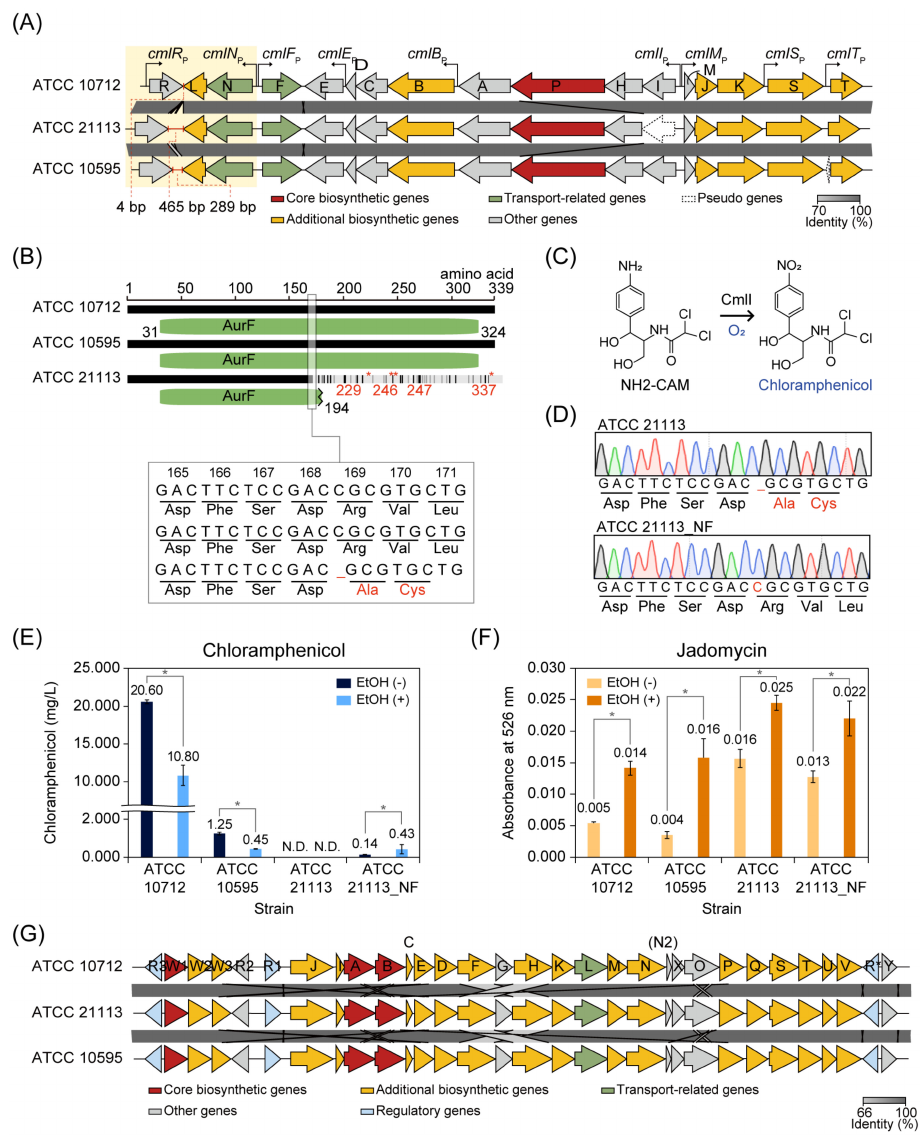
Figure 5. Comparison of chloramphenicol and jadomycin production. ( A ) Alignment of the chloramphenicol biosynthetic gene cluster (BGC) from the three S. venezuelae strains. The region of cmlR and cmlLN operon was represented with a yellow box, and the red line indicates the intergenic region of cmlR and cmlL . The genes were colored according to the classification of antiSMASH prediction. Gray bars between the clusters indicate BLASTn identity value. The chloramphenicol biosynthetic genes were named, according to Sekurova et al. [50]. ( B ) Comparison of amino acid sequences of CmlI from the three S. venezuelae strains. Amino acid 31 to 324 of the CmlI was predicted as the AurF domain by Pfam [51], and it was represented as a green rounded rectangle. The asterisk indicates the position of a stop codon. ( C ) N-oxygenation of NH2-CAM by CmlI to produce chloramphenicol. ( D ) Sanger sequencing results of the cmlI gene from ATCC 21113 and ATCC 21113_NF. ( E ) Chloramphenicol production of the three S. venezuelae strains and ATCC 21113_NF in the absence or presence of ethanol. EtOH, ethanol; N.D., Not detected. Asterisk indicates p -value < 0.05. (Wilcoxon rank-sum test) ( F )Jadomycinproductionofthethree S.venezuelae strainsandATCC21113_NFintheabsenceorpresence of ethanol. Absorbance at 526 nm was measured for estimating jadomycin production. EtOH, ethanol; Asterisk indicates p -value < 0.05. (Wilcoxon rank-sum test) ( G ) Alignment of the jadomycin BGC from the three S. venezuelae strains. The genes were colored according to the prediction of antiSMASH. Gray bars between the clusters indicate BLASTn identity value. The jadomycin biosynthetic genes were named, according to Niu et al.